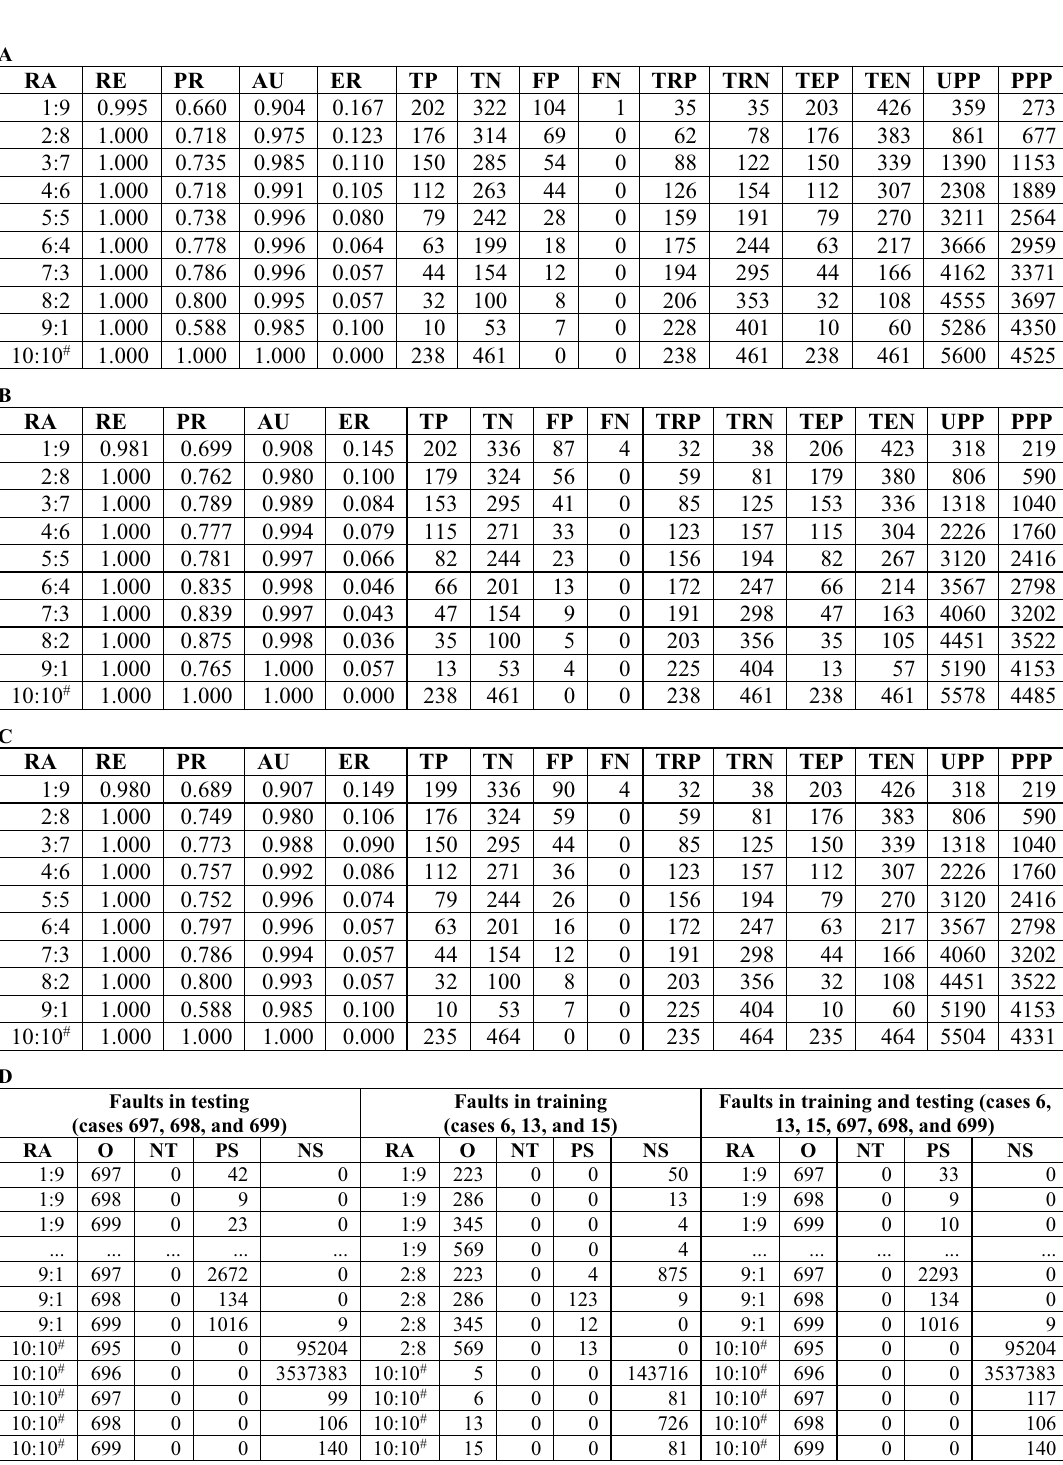
Figure 3. Tolerance to faulty class labels in BCWO ( B ). ( A ) For the case of testing, we change class labels of observations (i.e., 697, 698, and 699) from “1” to “0”. ( B ) For the case of training, class labels of observations (i.e., 6, 13, and 15) are changed from “1” to “0”. ( C ) For both cases, we change class labels of observations (i.e., 6, 13, 15, 697, 698, and 699) from “1” to “0”. ( D ) Although faults in testing, TC can still classify O 697 , O 698 ,